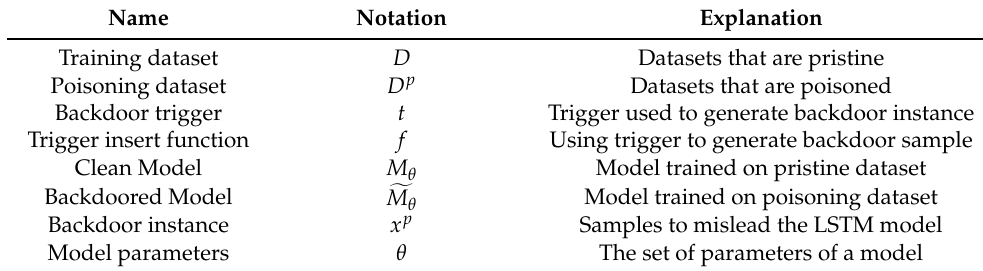
Table 2. Notions of Backdoor